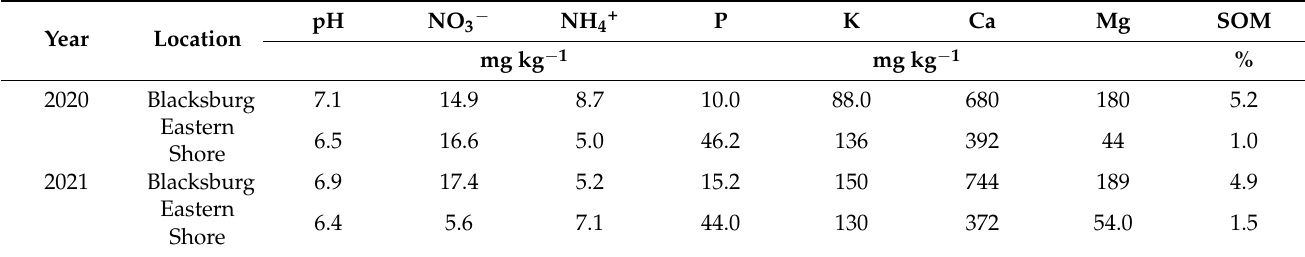
Table 1. Summary of soil chemical properties at Blacksburg and Eastern Shore sites in 2020 and